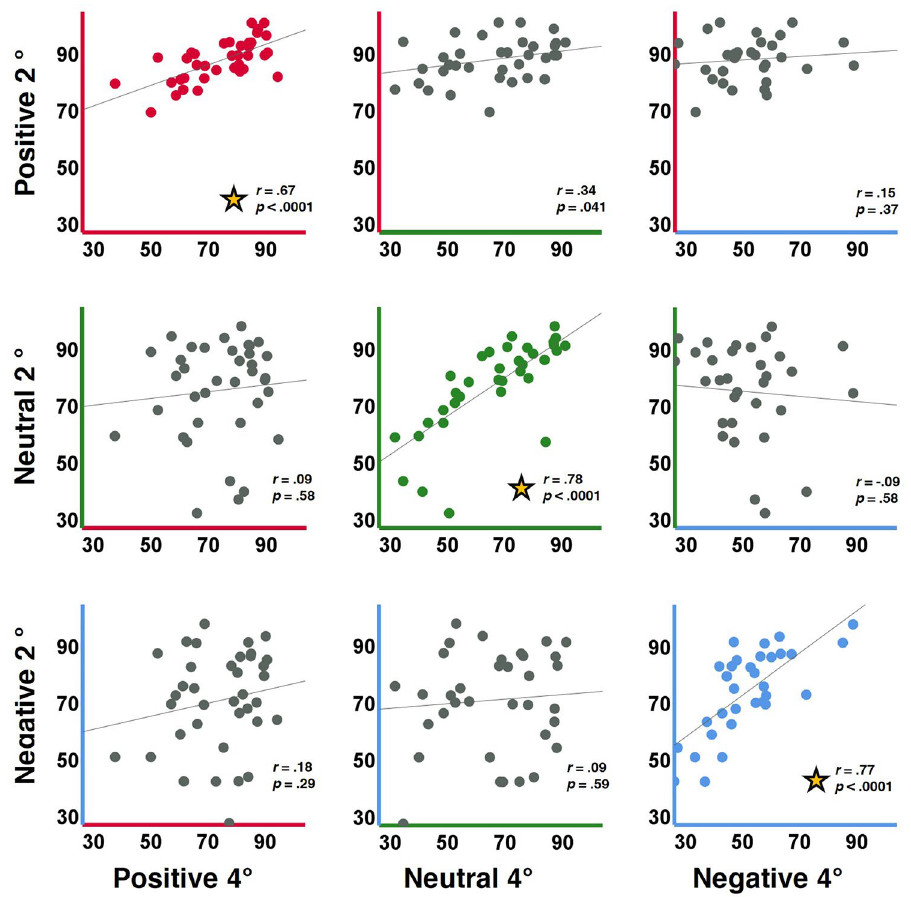
Figure 4. Within-valence but not between-valences performance is correlated across eccentricities (n = 37). Each scatterplot represents a comparison between parafoveal accuracies (2° on the y-axis by valence, 4° on the x-axis by valence). In each scatterplot each point represents performance of one participant in the single- trial experiment. R values represent correlation values, and p indicates non-corrected correlation significance (Bonferroni corrected p = 0.0056). Note that only within-emotion correlations (presented on the diagonal) were significant (surviving multiple comparisons correction, in bold, denoted by